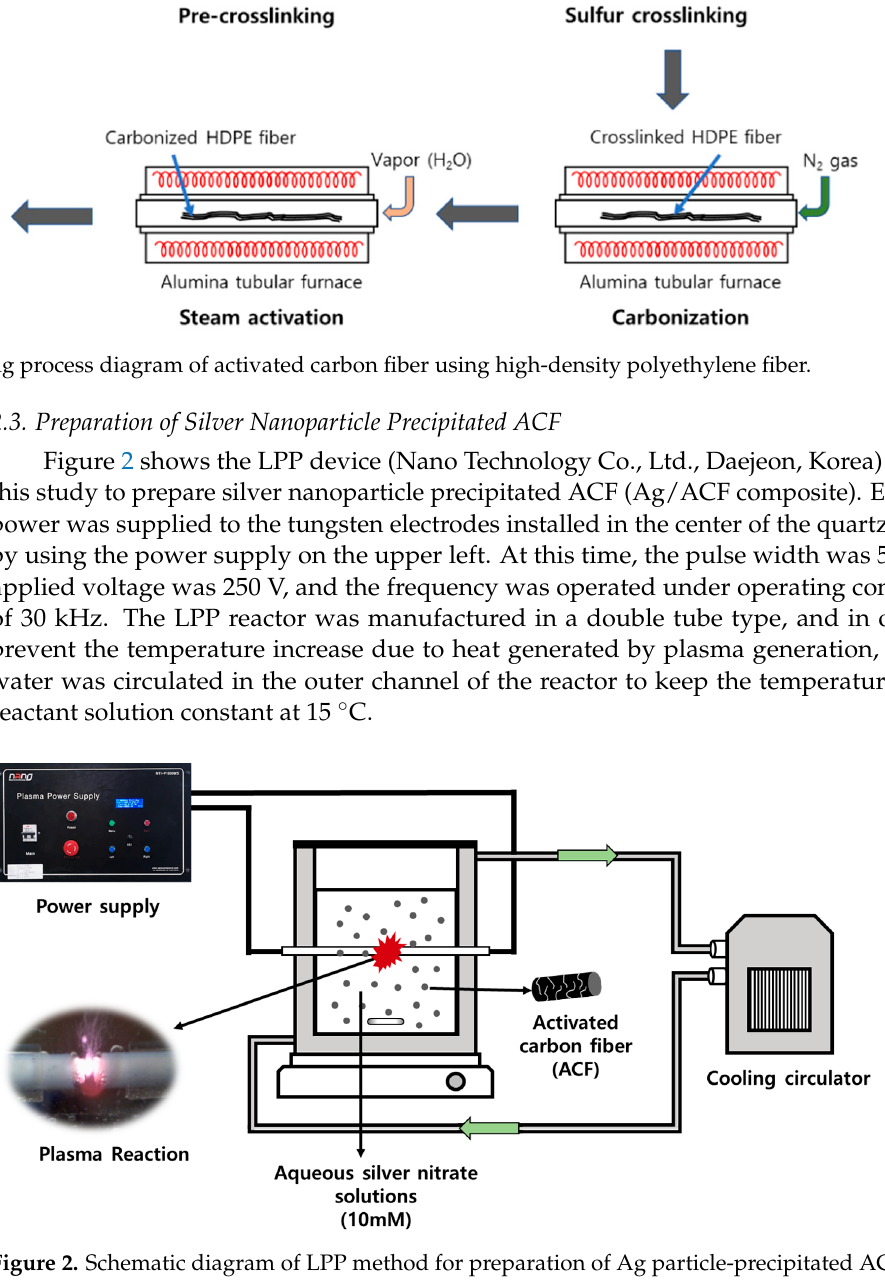
Figure 2. Schematic diagram of LPP method for preparation of Ag particle-precipitated ACF.